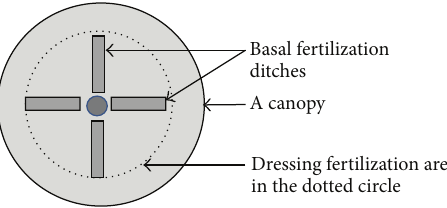
Figure 1: The diagram of fertilization area in the canopy projection area of an apple